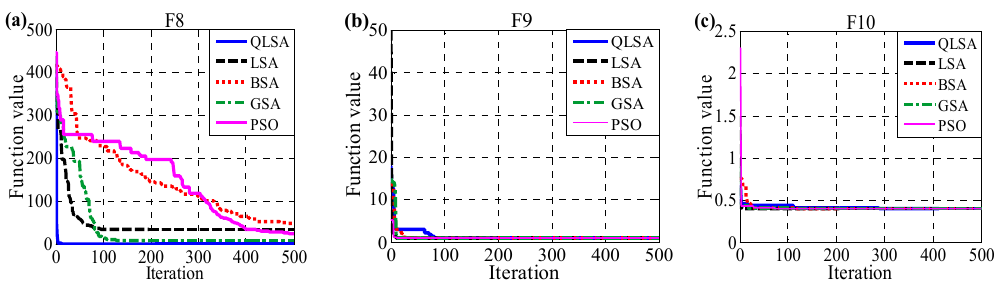
Figure 12. Convergence characteristic curves for QLSA, LSA, BSA, GSA and PSO in: ( a ) F8; ( b ) F9; ( c ) F10.